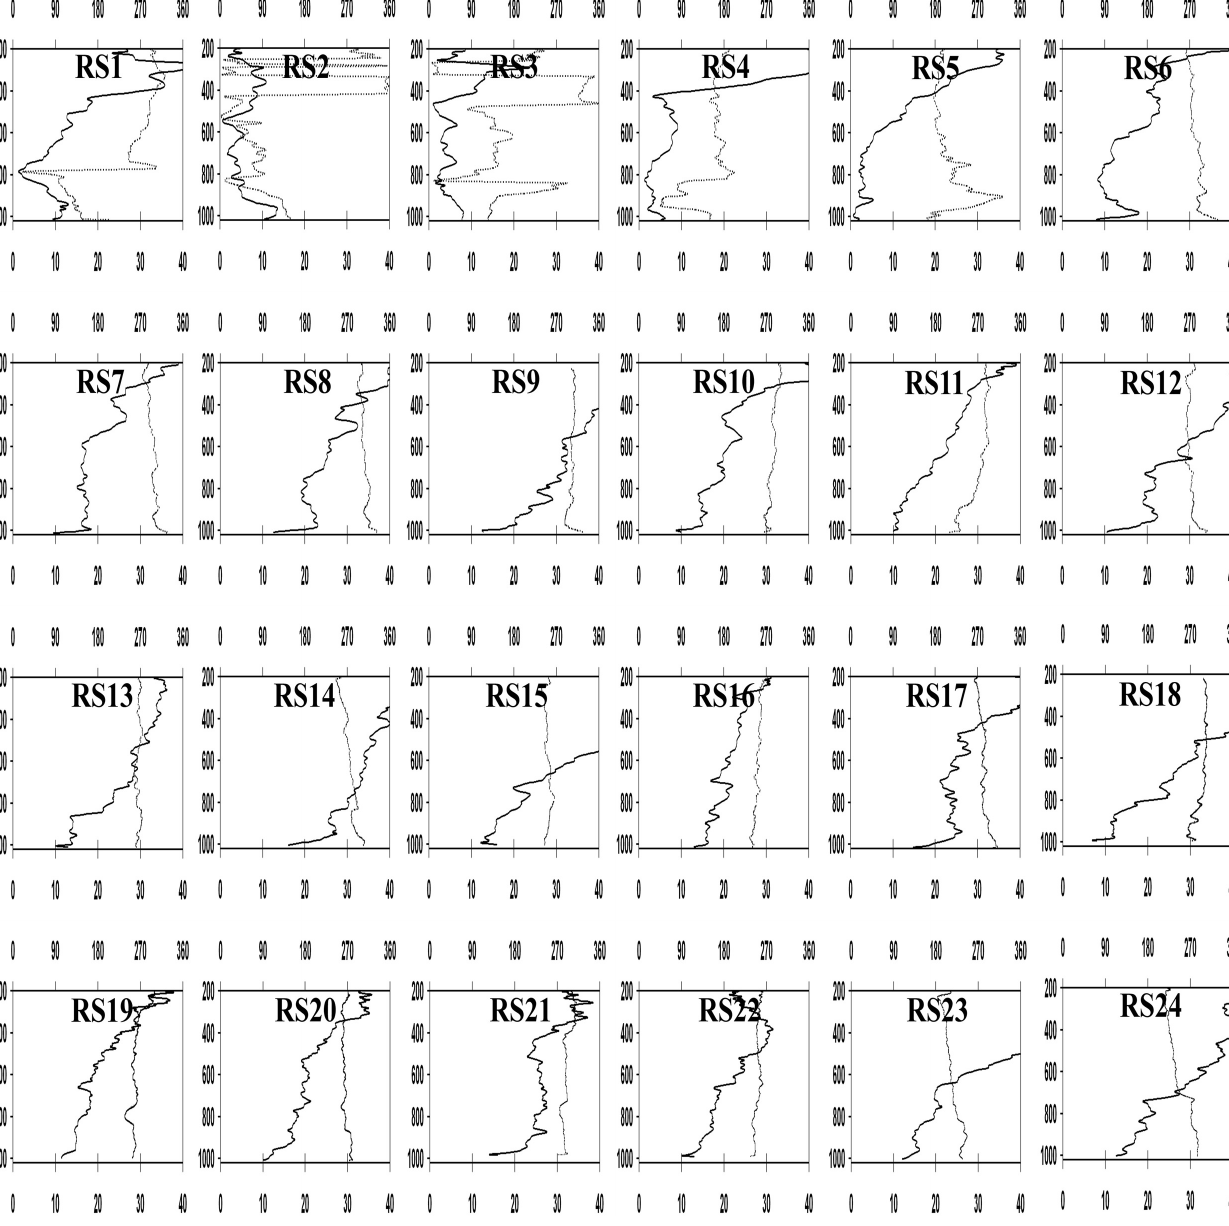
Fig. 4a. Vertical profile of wind speed in ms − 1 (bold line – lower horizontal axis) and wind direction in deg (dashed line – upper horizontal axis) for the 38 radiosondes. For locations, dates and times see Table 2. (a) for RS1 to RS24; (b) for RS25 to